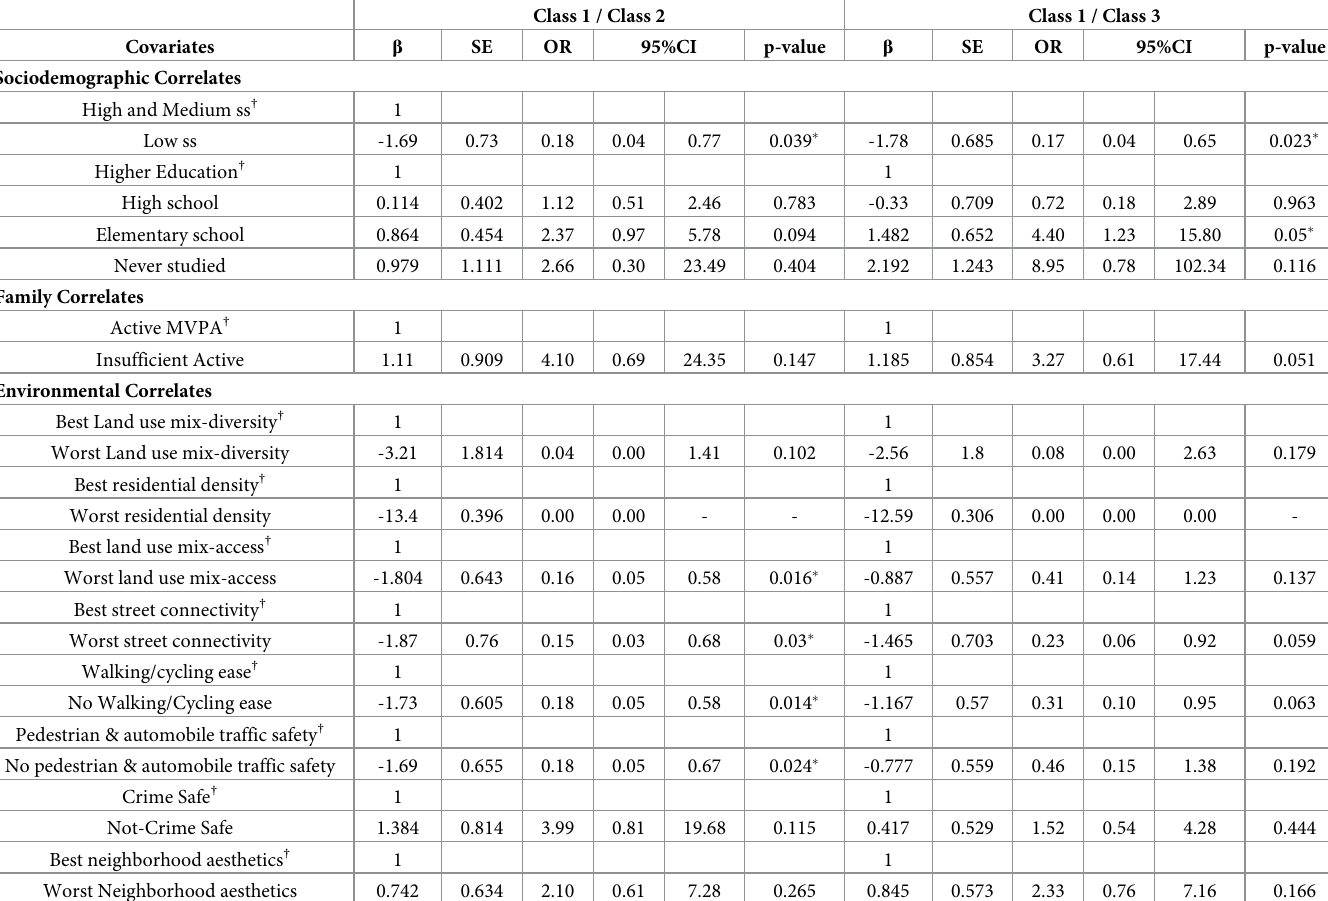
Table 3. Sociodemographic, family, and environmental covariates association with adolescent’s movement behaviors LCA